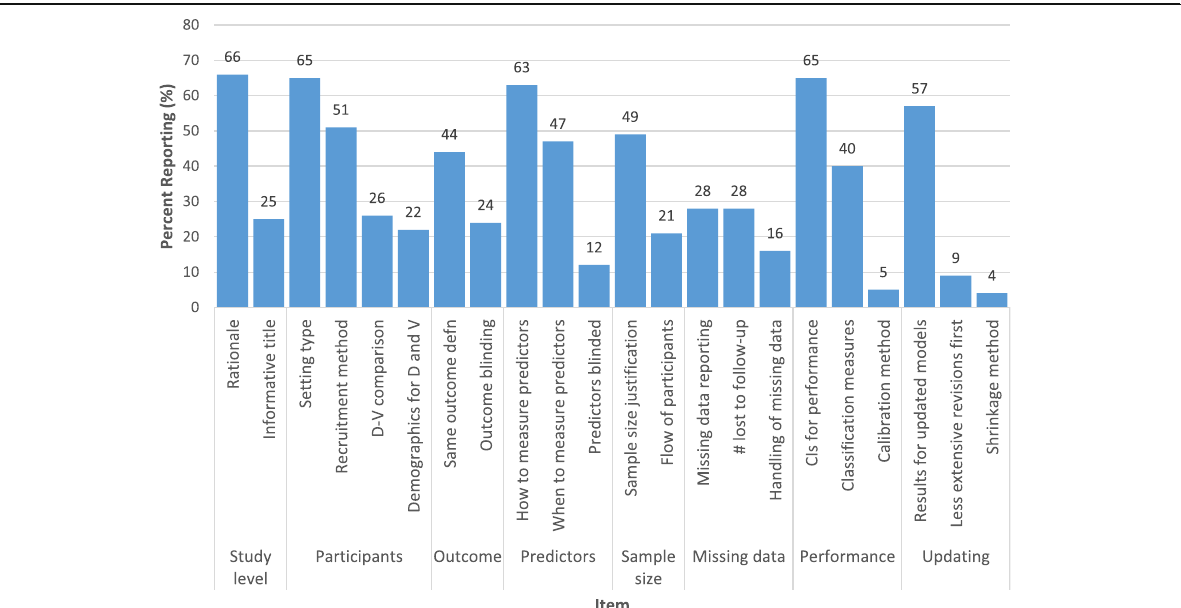
Fig. 3 Summary of reporting quality: percentage of studies adhering to each reporting item. D, derivation; V, validation; CIs, confidence